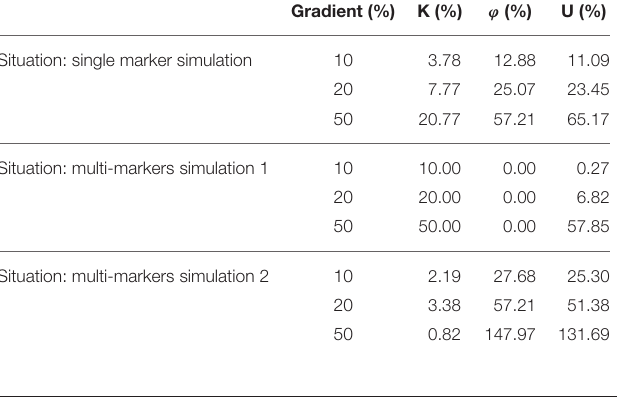
TABLE 2 | The mini network integral disruption parameters changes in simulation experiment.